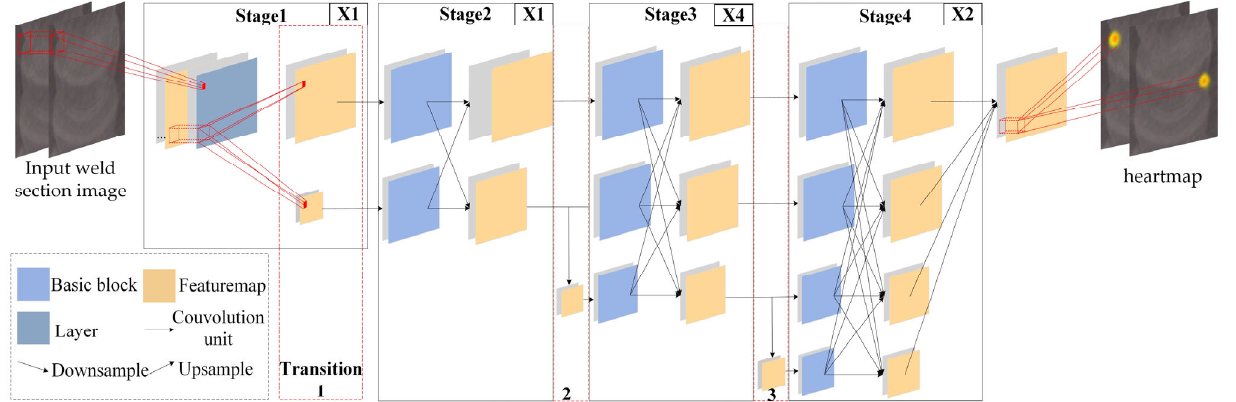
Figure 6. HRnet network structure diagram.